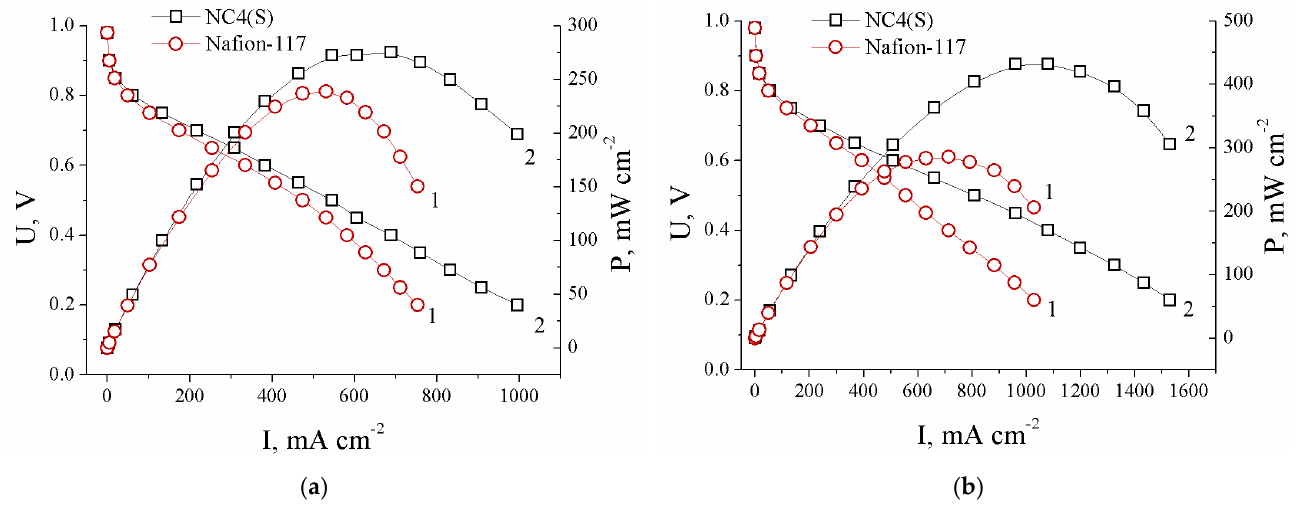
Figure 6. Polarization and power density curves for the MEAs with Nafion-117 (1) and the NC4(S) composite membrane (2) at 25 ° С , 100% RH ( a ), and 60 о С , 70% RH ( b ).